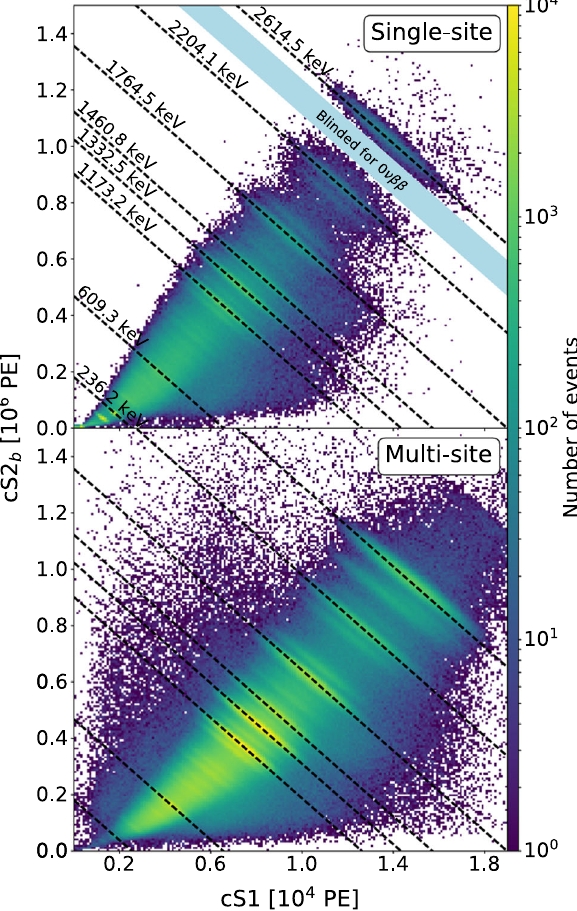
Fig. 4 Single-site (top) and multi-site (bottom) background event dis- tributions in corrected S1 (cS1), and corrected S2 bottom (cS2 b ), space. Mono-energetic photo-absorption peaks of gamma-rays are labelled with their energies and corresponding sources. SS events with energies around Q ββ are blinded